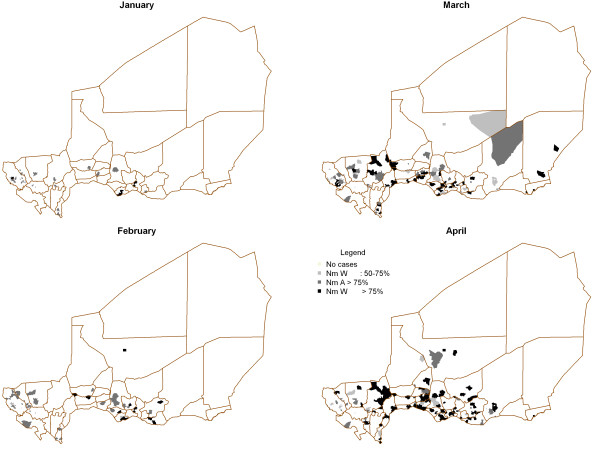
Spatio-temporal distribution of the percentage of Nm A and Nm W in health centre catchment areas (HCCA) of Niger between January and April 2010.